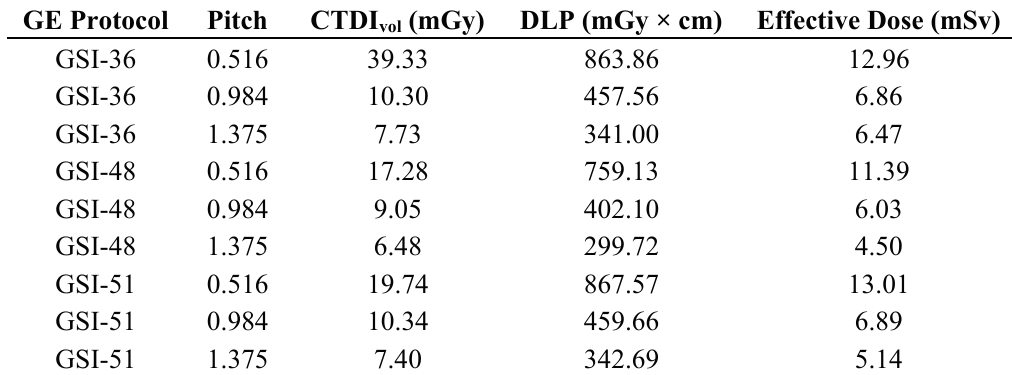
Table 4. Summary of CTDI vol values, dose-length products, and effective doses across the